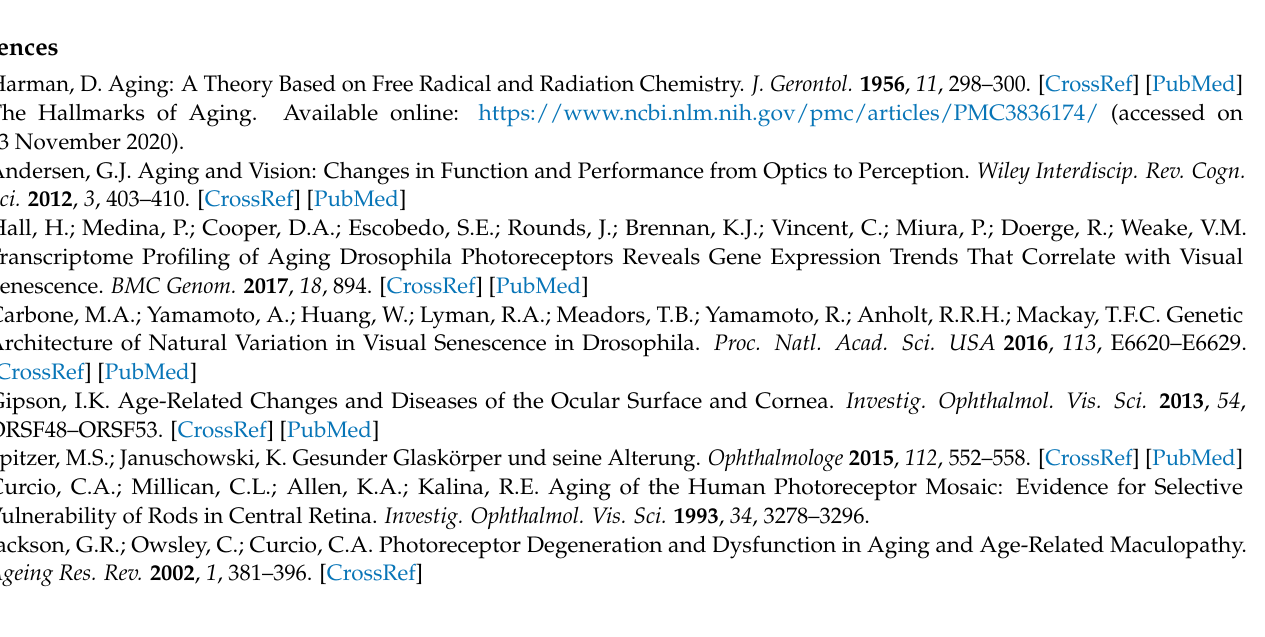
optical stimulator, Table S1: Differentially expressed genes with blue light or aging, Table S2: Enriched GO terms, Table S3: Blue light/aging GO terms upregulated genes, Table S4: Blue light/aging GO terms